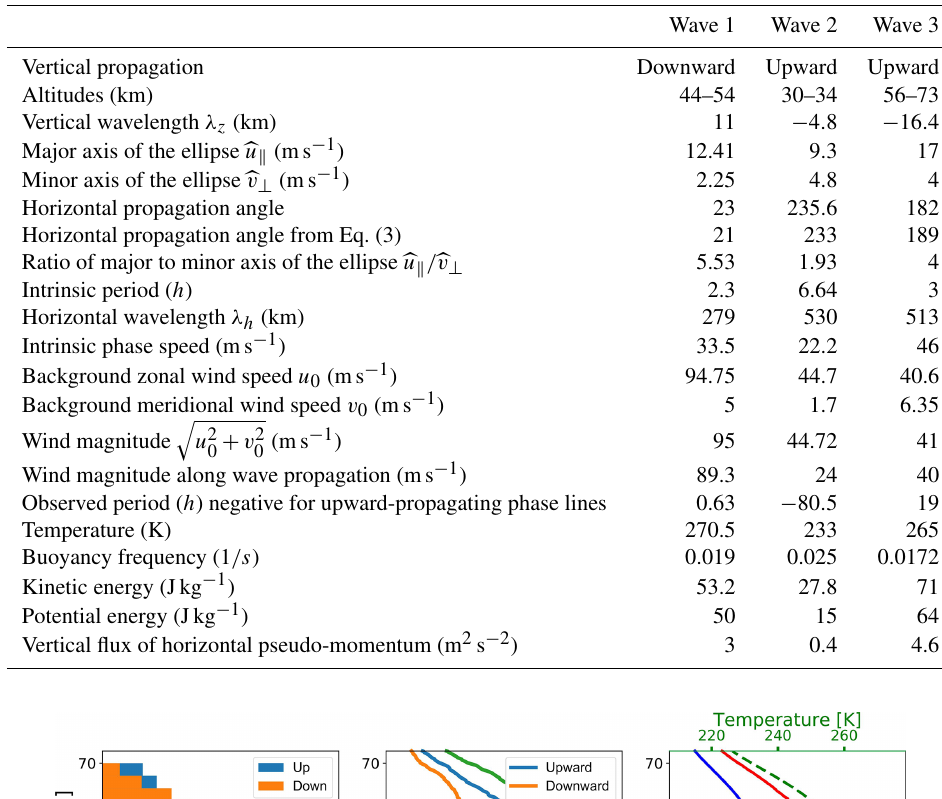
Table 1. Examples of hodograph results from 10 January 2016 at 02:07:30UT.